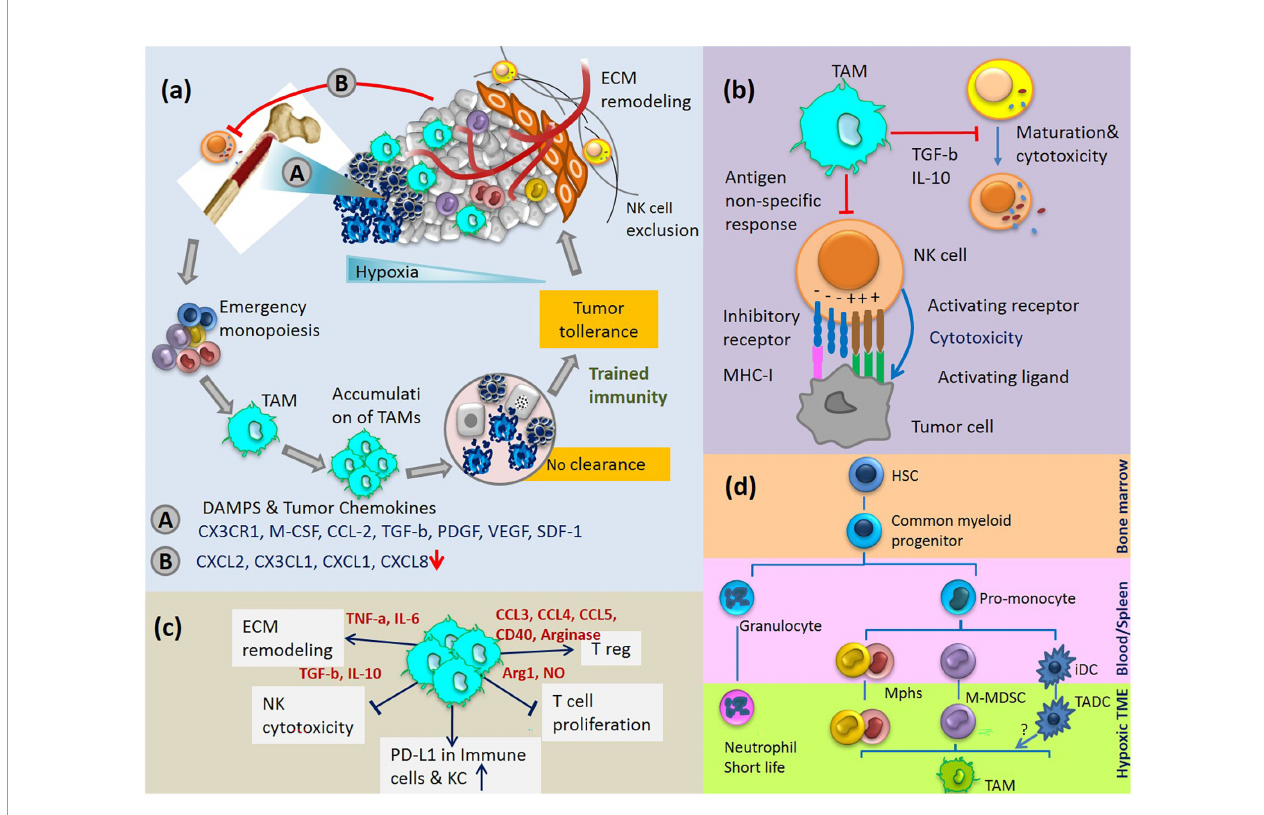
FIGURE 2 | (A) Cycle of emergency monopoiesis, accumulation of immature suppressive macrophages in TME, inhibition of CD56dim NK cell egress from BM and their exclusion from tumor are part of the synchronize program which causes immune tolerance to HCC. (B) TAM inhibits NK cell cytotoxicity and maturation. (C) Immunosuppressive activities of TAMs. (D) TAMs differentiation pathway: myeloid cells originate from HSCs in the BM and differentiate into various myeloid cell lineages in blood, spleen and tumor tissue. Various monocytic cells in TME change to polarized phenotypes between M1-M2. iDC, immature dendritic cells; TADC, tumor-associated dendritic